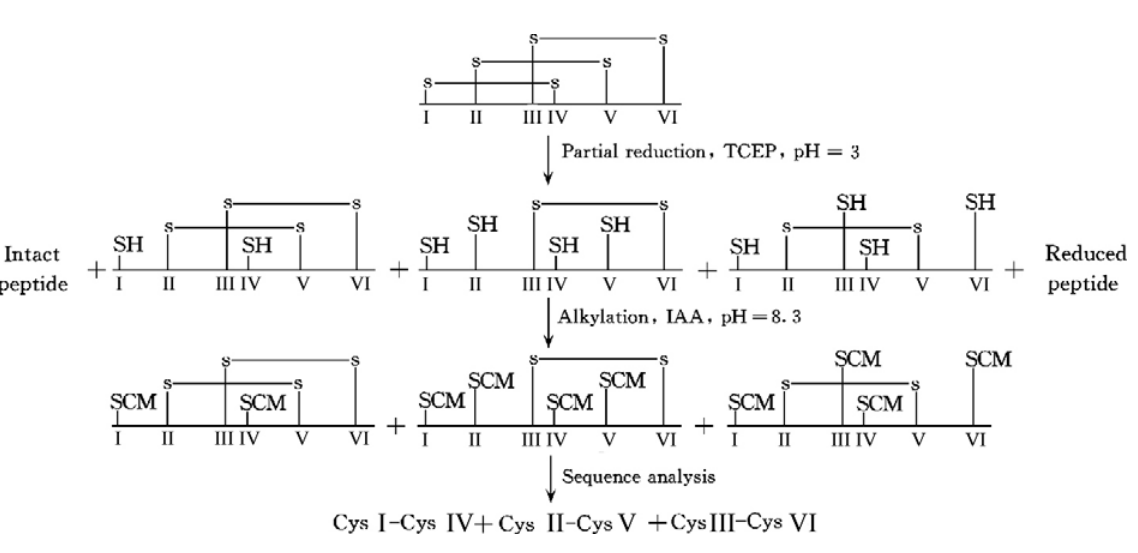
Figure 1. Chemical overview of the methodology. The Roman numerals below the sequences show the order of cysteine residues in the